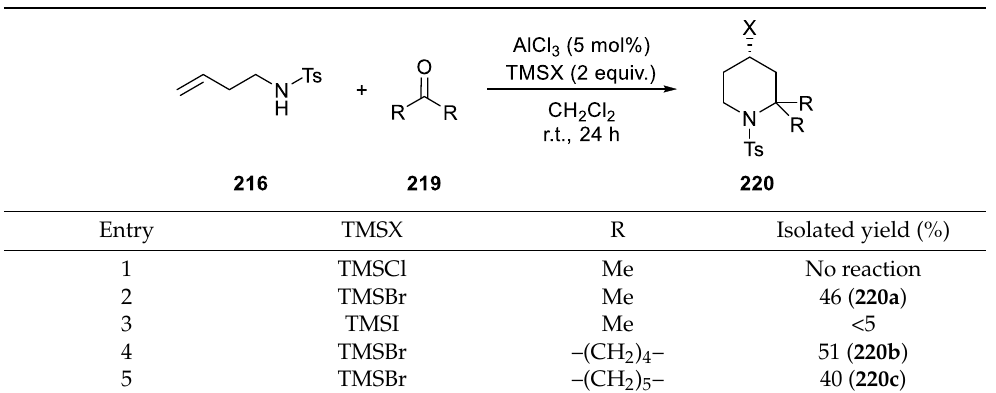
Molecules 2023 , 28 , x FOR PEER Table 9. AlCl 3 -catalyzed Prins reactions of different ketones with N -tosyl homoallylamine.